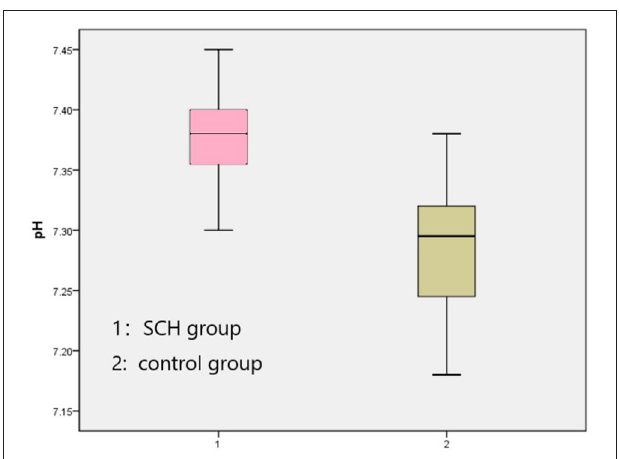
FIGURE 1 | Comparison venous pH between two groups.